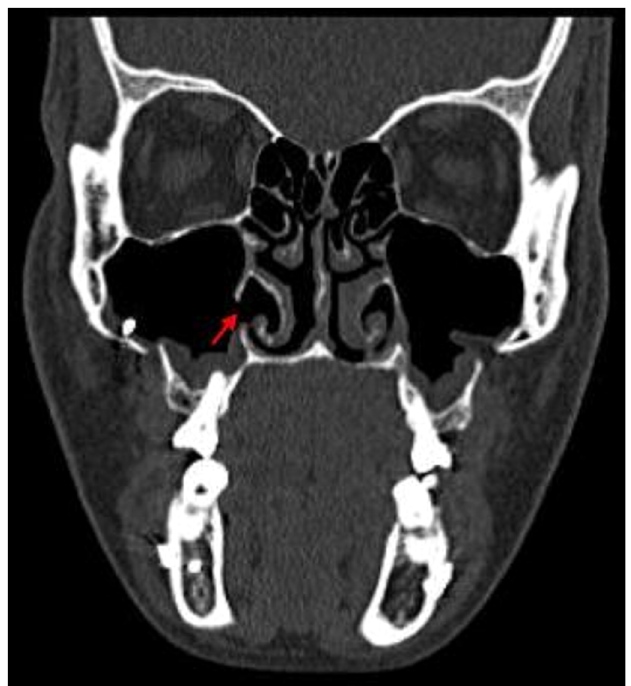
Fig. 4. Preoperative coronal CT image showing unilateral sinusitis which was clinically silent on left side